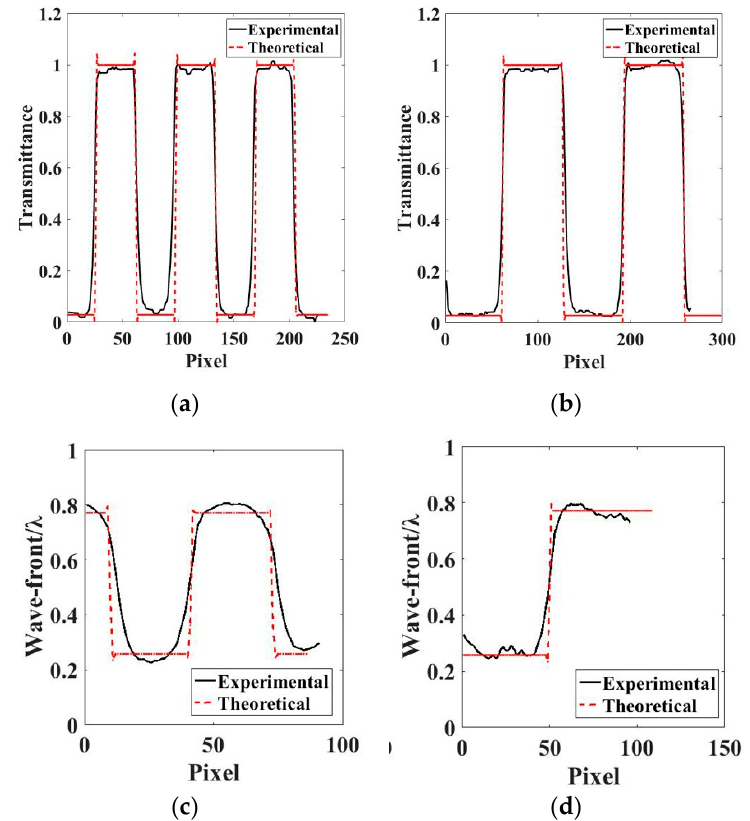
Figure 10. ( a ) 1D transmittance in the horizontal direction. ( b ) 1D transmittance in the vertical direction. ( c ) 1D wave-front in the horizontal direction. ( d ) 1D wave-front in the vertical